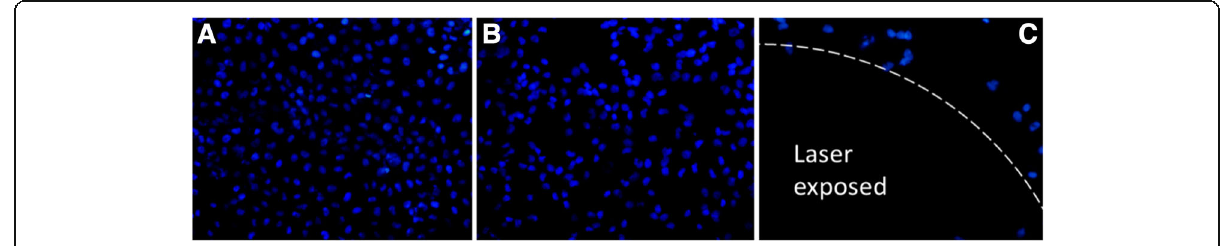
Fig. 11 CLSM images of DAPI (blue) stained cell nuclei after treating with NrGO ( a ), DOX@NrGO ( b ), and DOX@NrGO+NIR ( c ). (× 400)